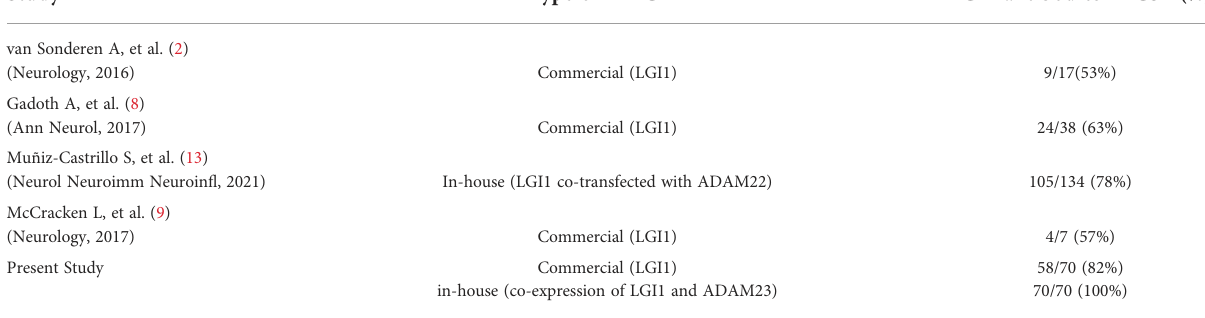
TABLE 2 Reported results for LGI1 antibody detection in CSF by IIF-CBA.